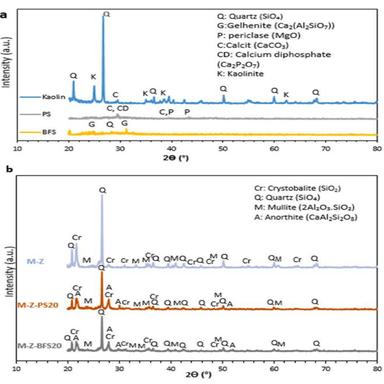
XRD pattern of a) raw materials and b) tubular membranes.